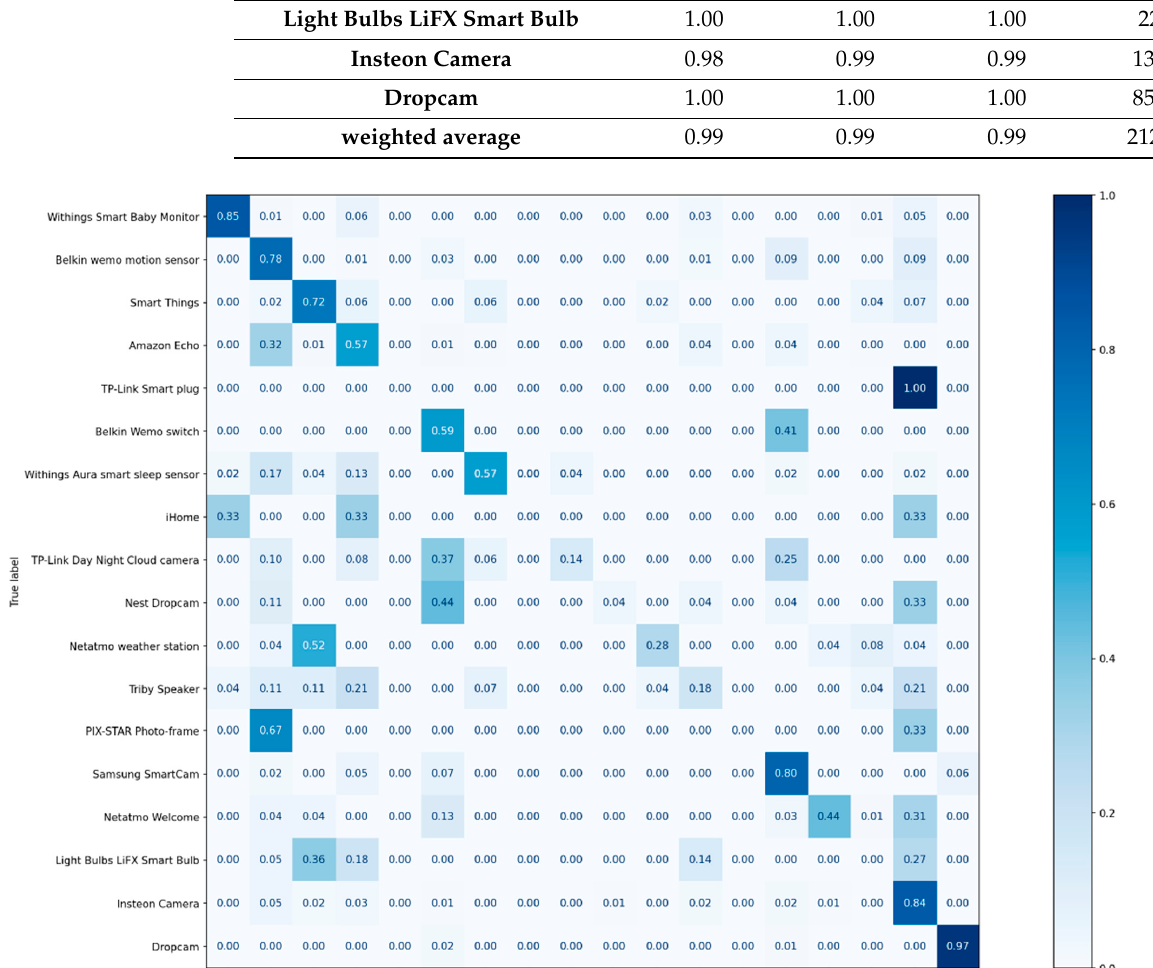
Figure 9. The confusion matrix of the classification results for the MLP. Table 10. The precision, recall, and f1-score results and the numbers of test data for the CNN.